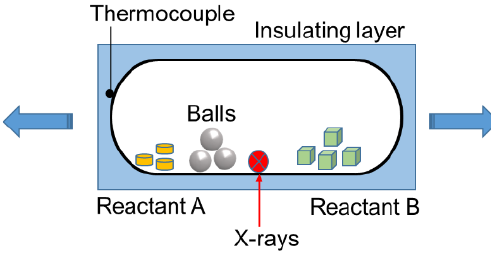
Figure 3. PMMA reaction vessel in an insulating housing for in situ X-ray diffraction monitoring of mechanochemical reactions at elevated temperatures. The X-ray beam is passing the vessel through the bottom, indicated by the illustrated red circular cross-section. The arrows indicate the direction of the vessel movement during milling. Adapted with permission from [51]. Copyright 2016, American Chemical Society.